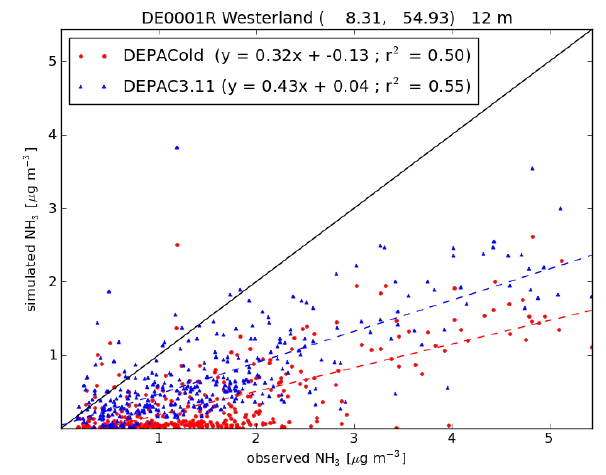
Figure 12. Scatter plot for the daily mean measured and modeled ammonia concentrations with the 'DEPACold' module (red dots) and the 'DEPAC3.11' module (blue dots) at EMEP station Westerland in Germany in 2007. The grid resolution of the model results is 0.50° longitude x 0.25° latitude (~28x28 km 2 ).